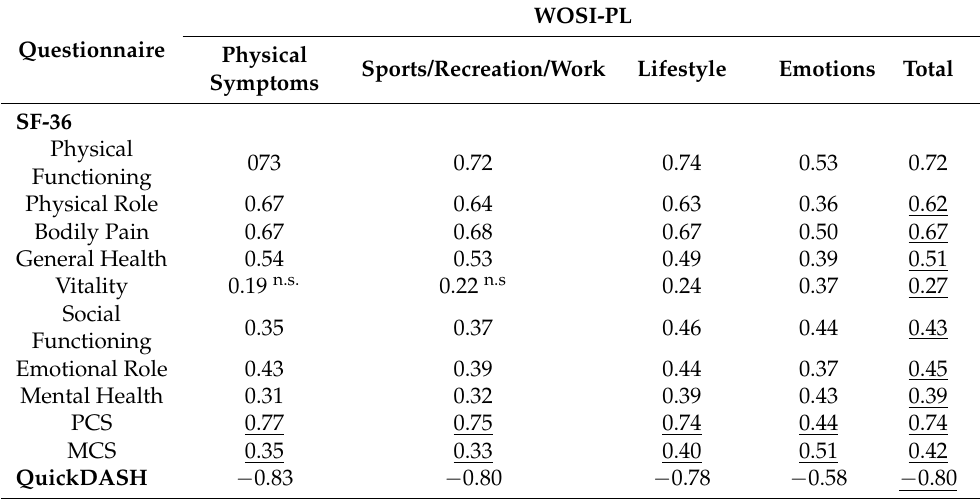
Table 5. Correlations (SCC) between the WOSI-PL (domains and total score) and reference question- naires ( n =